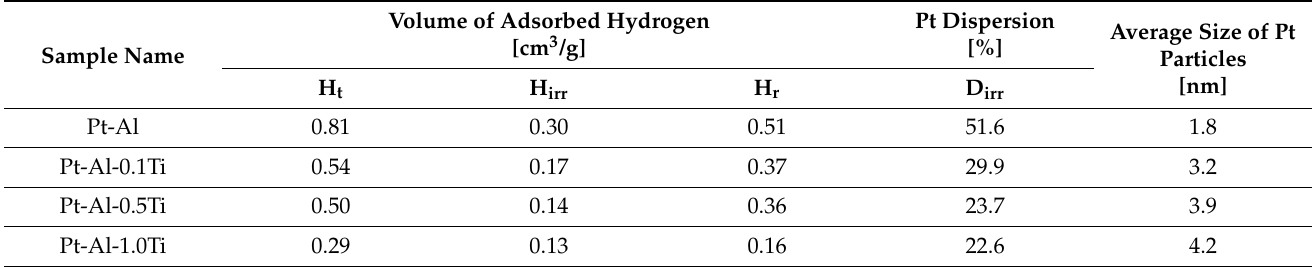
Table 3. Hydrogen chemisorption on platinum catalysts reduced at 400 ◦